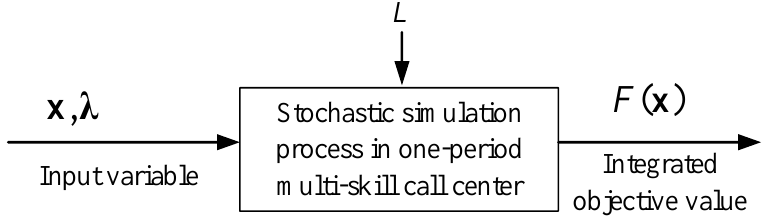
Figure 4. Input output relationship in a one-period multi-skill call center.